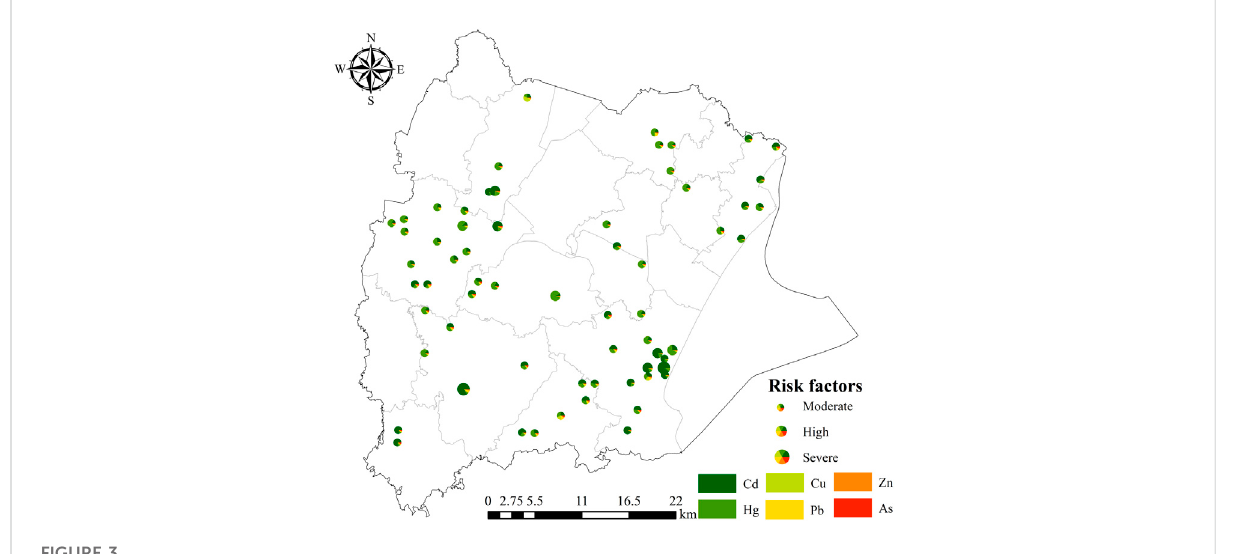
FIGURE 3 Contribution of different heavy metal risk factors at risk sites.